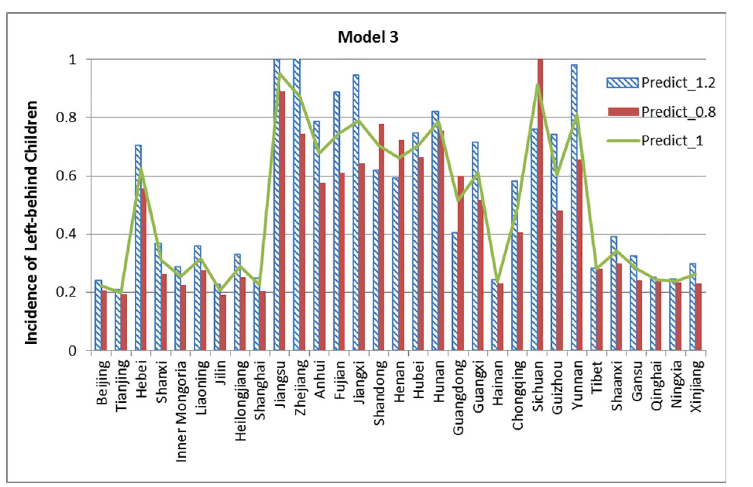
Fig 22. Simulation results of Model